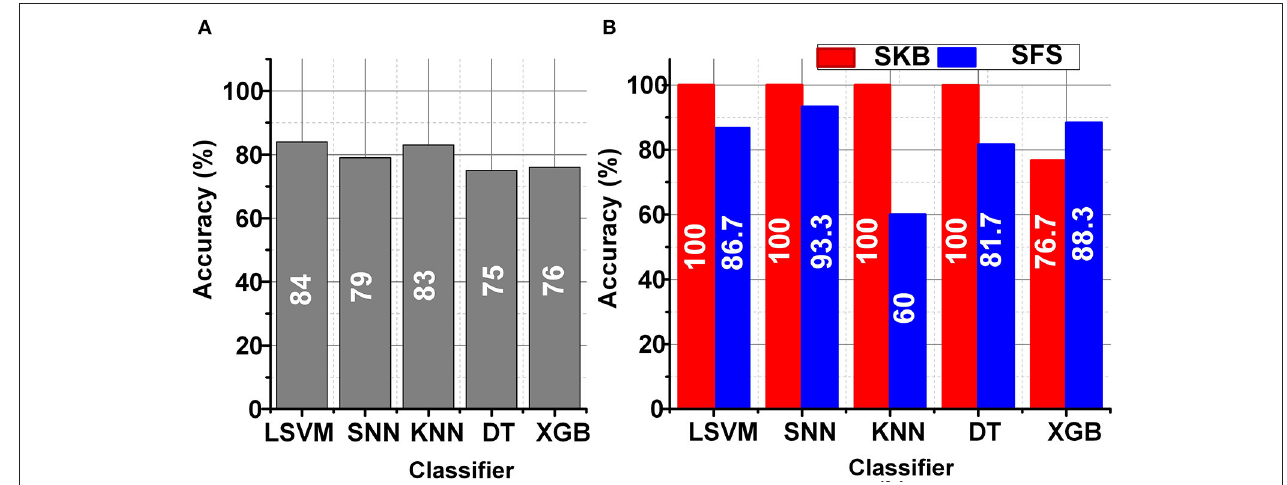
FIGURE 9 | Classification results for ASD classification (A) before FS (B) after FS using ODU data set.